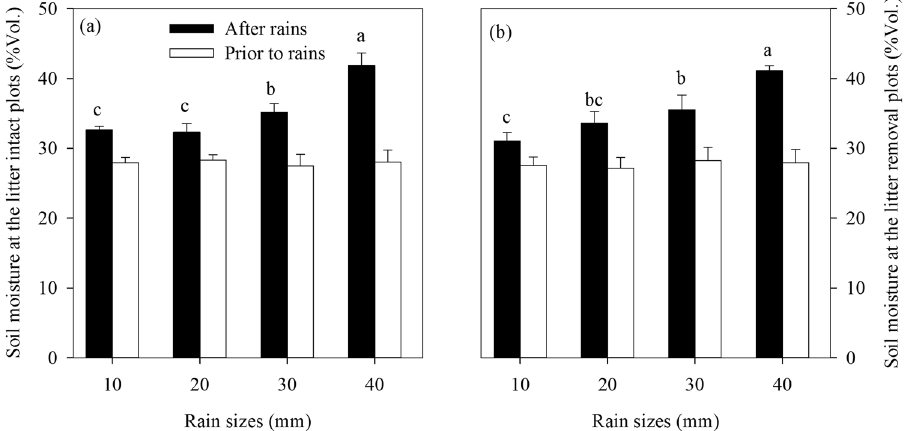
Figure 1. Soil moisture (%Vol.) prior to and after simulated rains with different rain sizes. Different letters over the bar indicate statistically significant differences in the litter plots. Values are means ± SE (n = 5). Litter treatments have no effect on soil moisture in all rain sizes, thus soil moisture after rains was calculated by averaging the litter and bare plots. No significant difference in soil moisture among the rain sizes was found in the bare